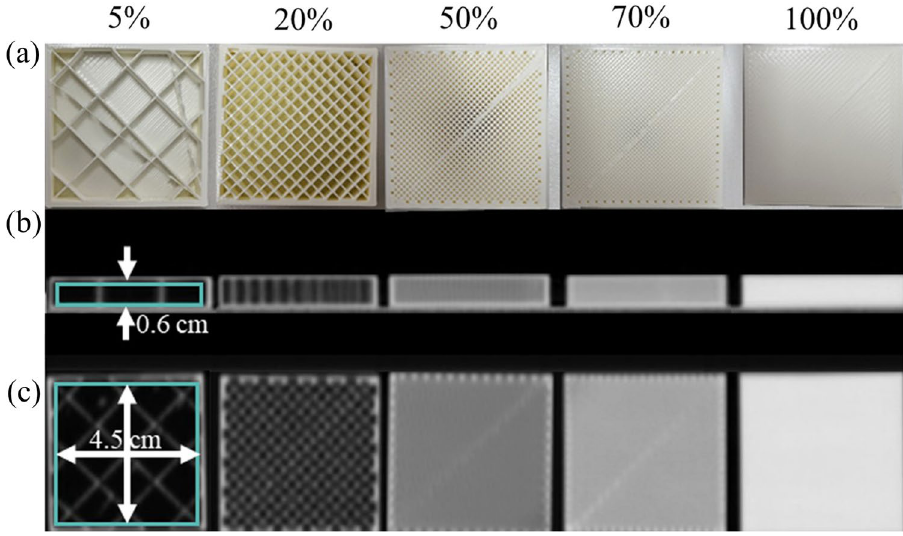
Figure 2. ( a ) Photograph of the cuboid specimens with infill values of 5%, 20%, 50%, 70%, and 100%. ( b ) Transversal and ( c ) frontal plane images of the cubic phantom with infill values obtained by CT scan.